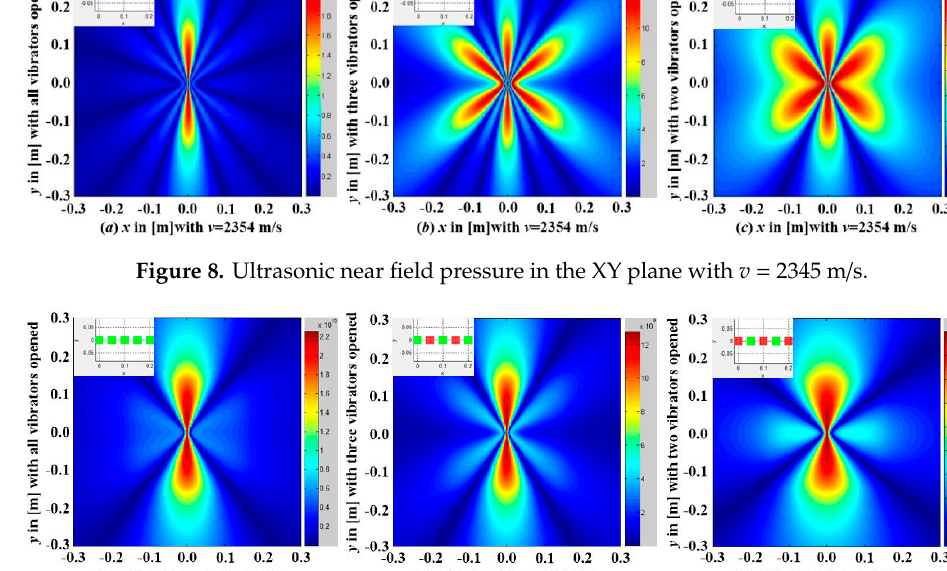
Figure 9. Ultrasonic near field pressure in the XY plane with v = 4674 m/s.